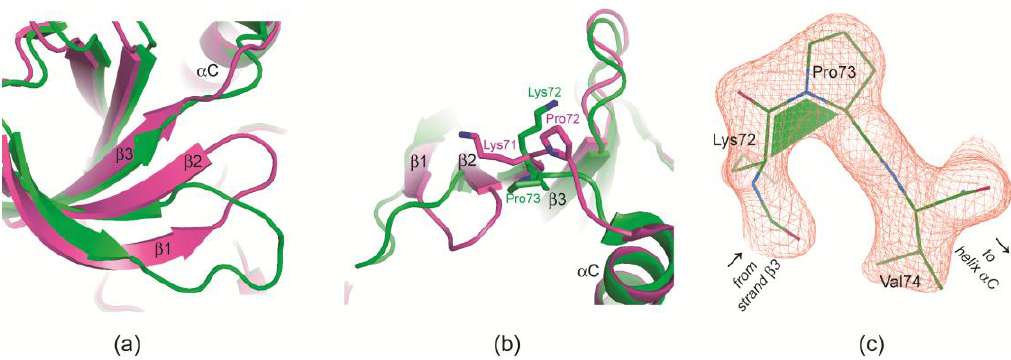
Figure 5. Strong deformations of the ATP-binding loop of CK2α/CK2α′ can be correlated with cis -peptide formation at the central proline residue of the β3/αC loop. ( a , b ) Overlay of protomer B of the monoclinic CK2α′ Asp39Gly/Cys336Ser /FLC21 complex structure (structure 2 in Table 1; green) and a high-resolution structure of human CK2α 2–331 in complex with an ADP-analogue (PDB 3NSZ [37]; magenta). The canonical β-sheet of the N -terminal domain is drawn in two different orientations; ( c ) the β3/αC loop in protomer B of the monoclinic CK2α′ Asp39Gly/Cys336Ser /FLC21 complex structure covered by electron density (cutoff level 1.5 σ).